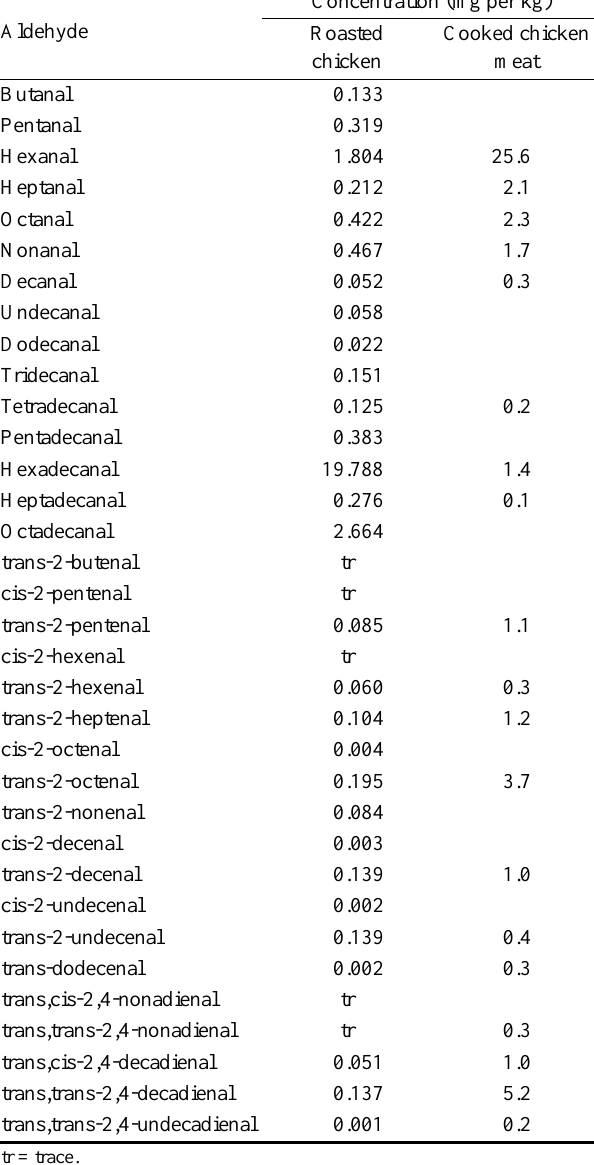
Table 2. Selected aldehydes identified in roasted and cooked chicken flavour (adapted from Shi and Ho, 1994) Aldehyde